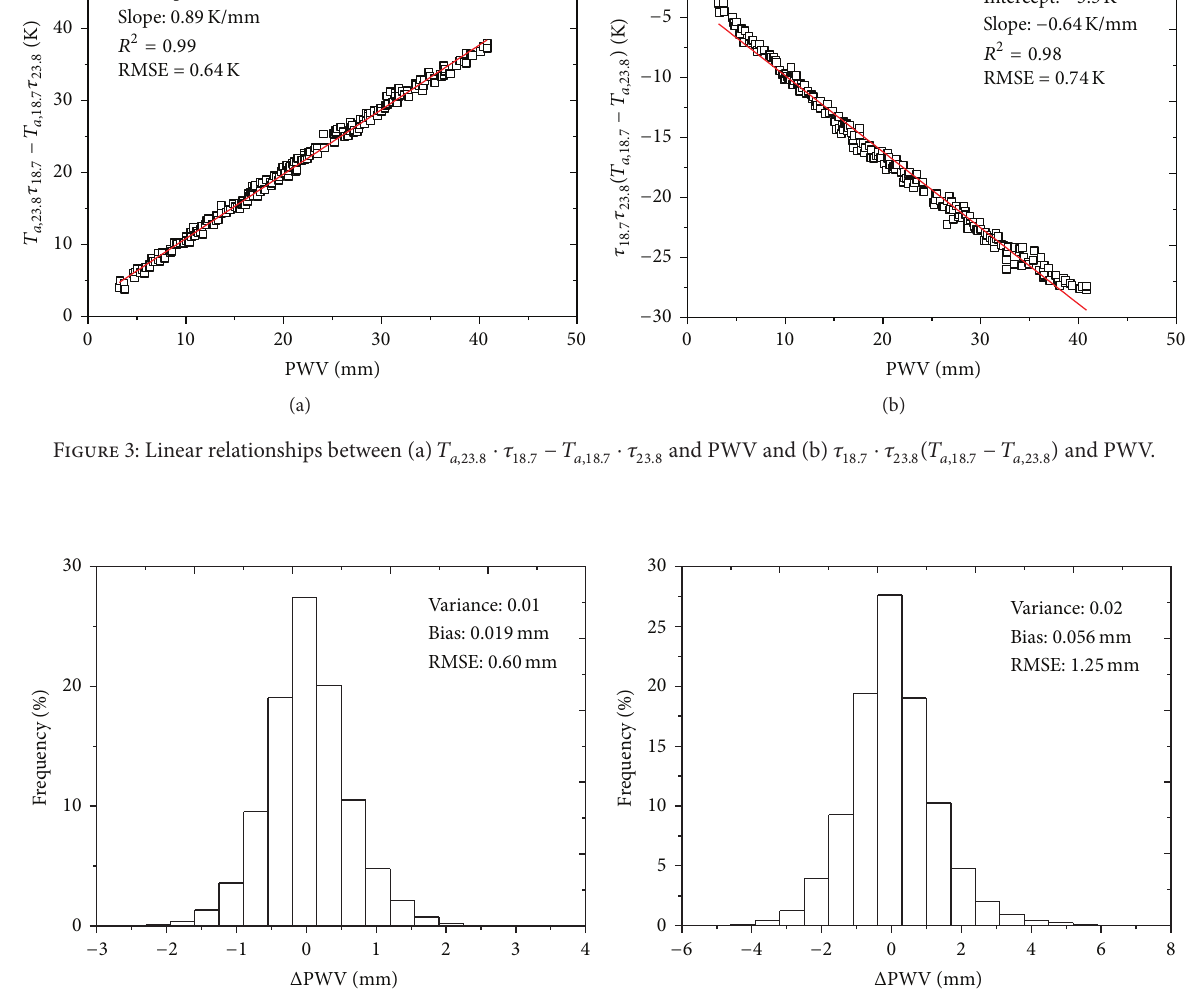
2 mm and less than 0.3% of errors are over 4 mm, which indi- cates that the PWV model is not sensitive to error in 𝑇 𝐵,18.7